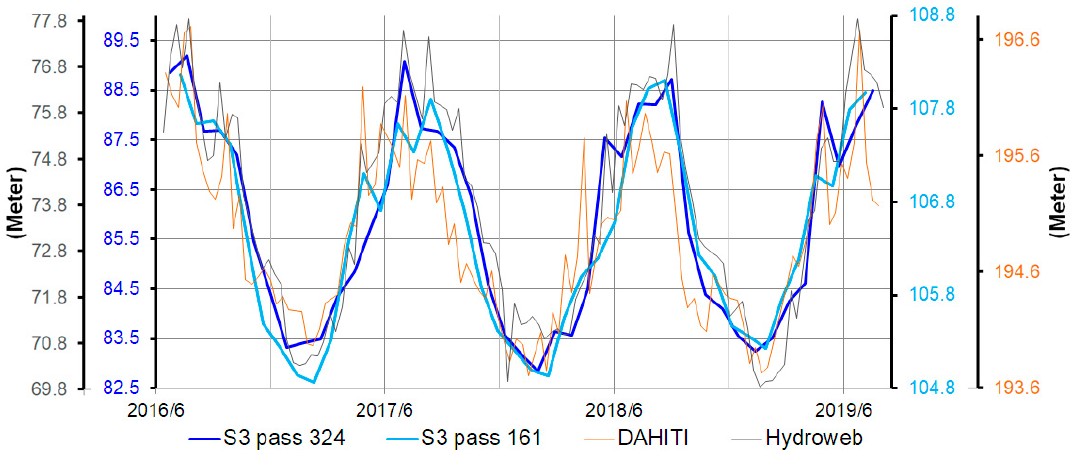
Figure 10. The time series water level of the Brahmaputra River estimated with Sentinel-3. The internal cross-comparison with different Sentinel-3 passes, and the external comparison with altimetry databases are illustrated. Note that the VS of each record is different, so the magnitude of water level variations differ, while the similar trends are still identifiable.